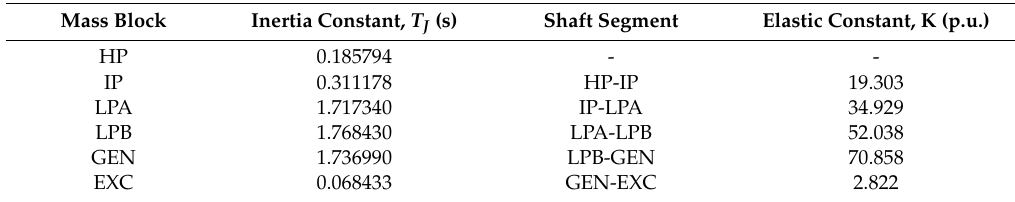
Table 2. Turbogenerator shaft parameters